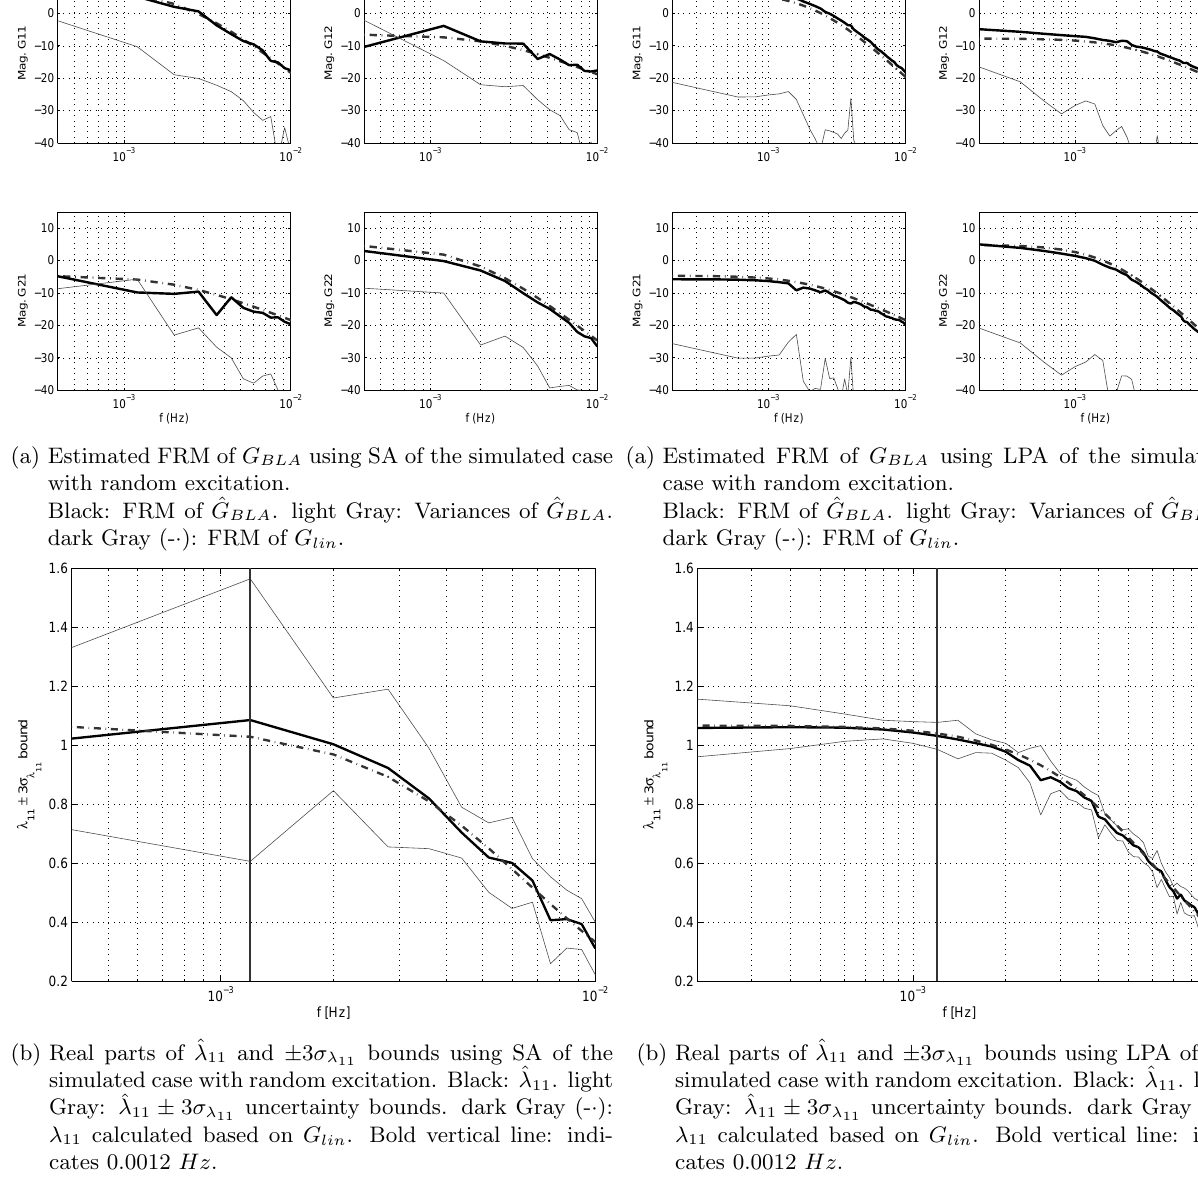
Figure 5: Simulation results of ˆ G BLA and ˆ λ 11 using LPA